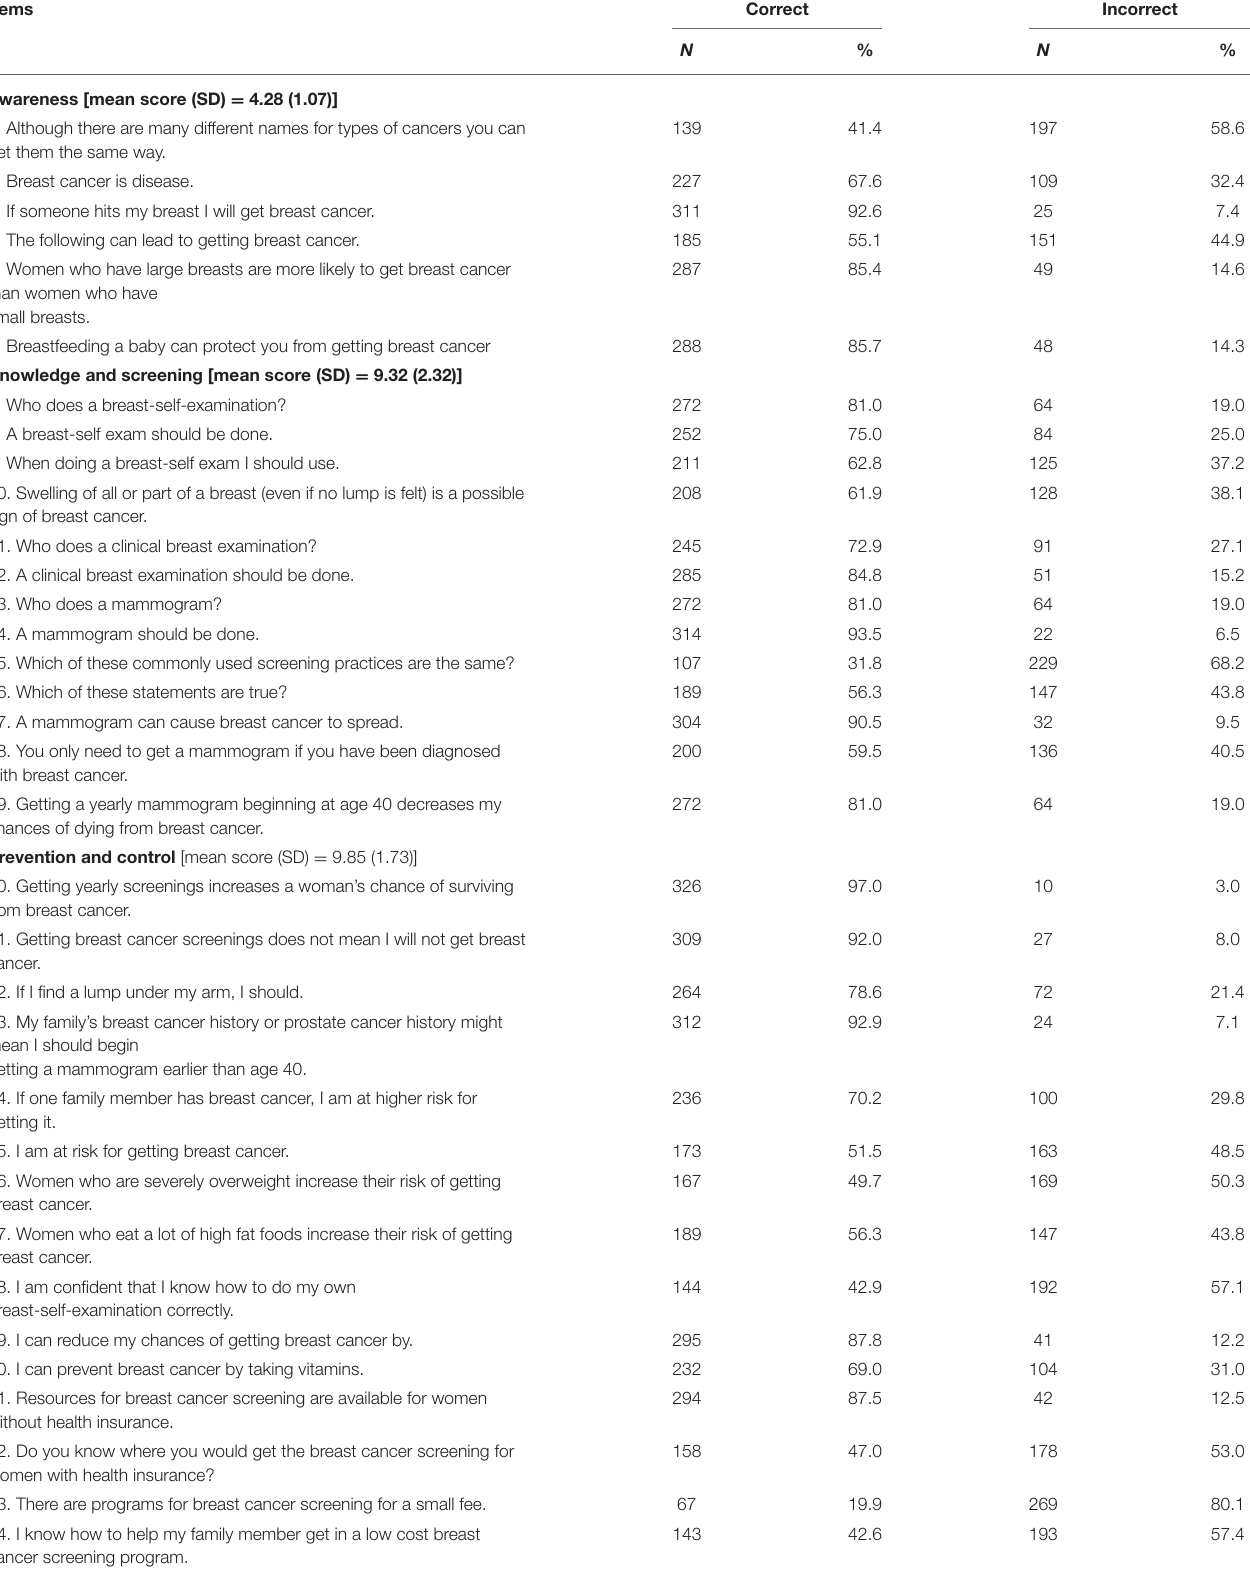
TABLE 3 | Breast cancer literacy of Saudi women ( N = 336). Items Correct